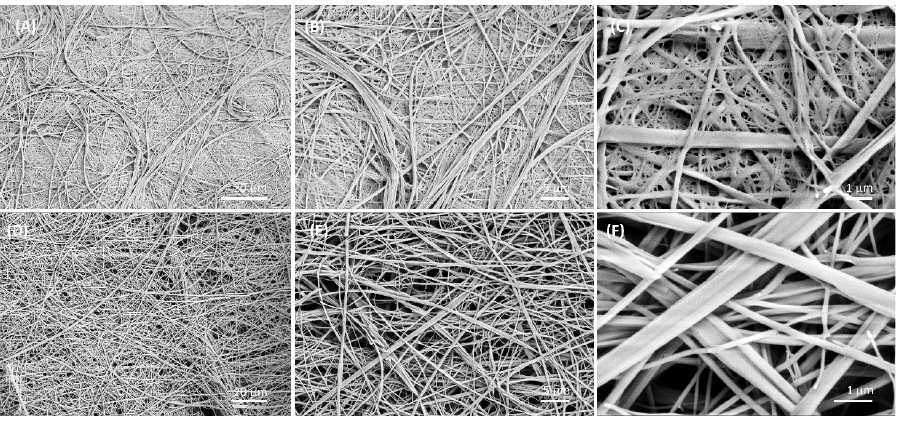
Figure 5. SEM images of the xerogels at increasing magnifications: ( A – C ) XG1 xerogel and ( D – F ) XG02 xerogel.